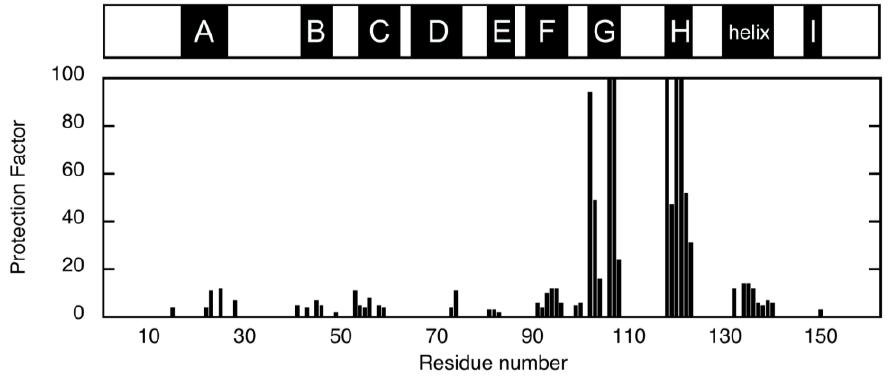
Figure 3. Protection factors of backbone amide protons in the A state at pD 1.5 and 25 °C [22]. The upper bar indicates the location of the secondary-structure units in the N